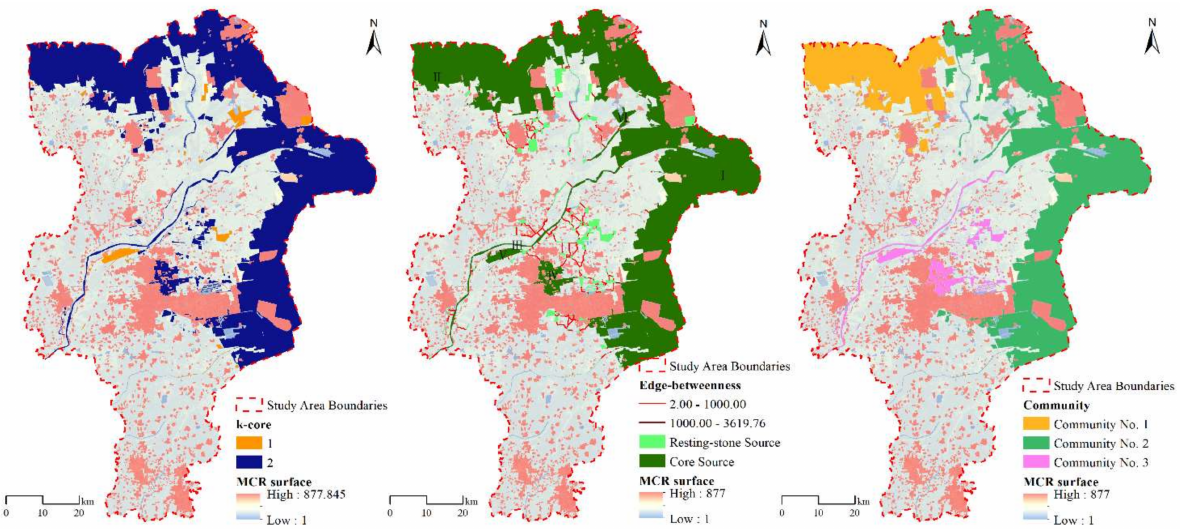
Figure 8. Distributionofk-core( left ),edge-betweenness( middle ),andcommunity( right )inDongying